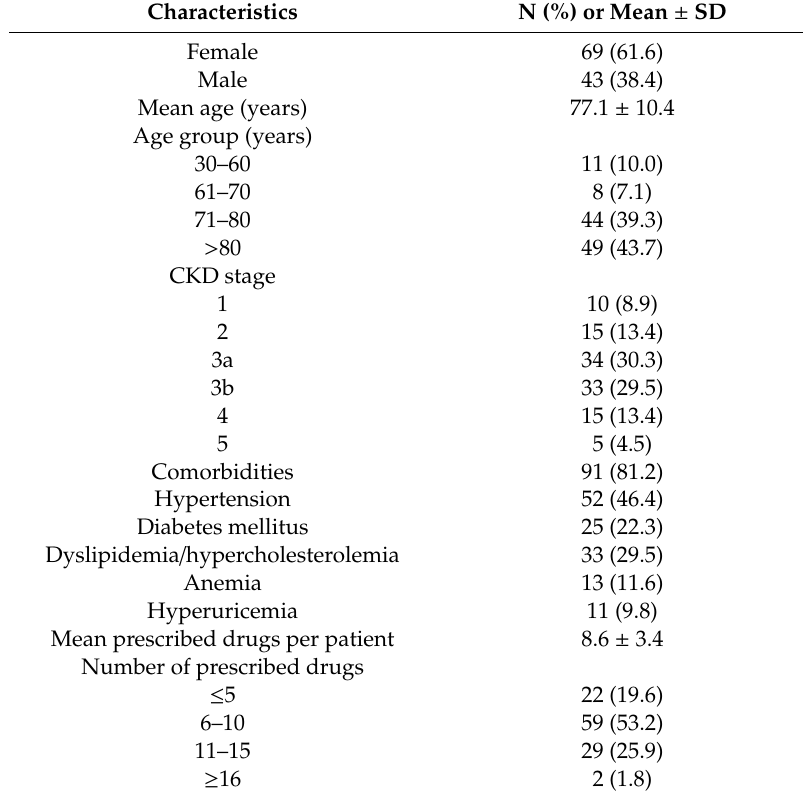
Table 1. Characteristics of the study population (n =